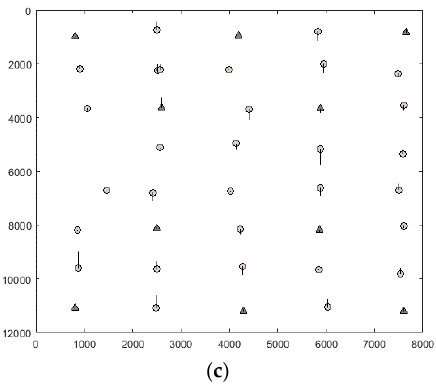
Figure 9. The scatter plot of the vertical parallaxes on the normalized imagery in Experiments 2, 6, and 10 with a magnification factor of 10,000: ( a ) Isfahan dataset; ( b ) Zanjan dataset; ( c ) Fars dataset. As the final note on Table 4, the proposed model has a high ability to provide a linear relationship between the vertical parallax of ChCP and their heights in the object space. Since the height of ChCP have been calculated using the space intersection process and the EOP of original stereo imagery have been directly estimated using GCPs, the computed heights’ accuracy of ChCP depends on the accuracy and distribution of GCPs, along with the image coordinates’ accuracy of both the CoCP and ChCP.